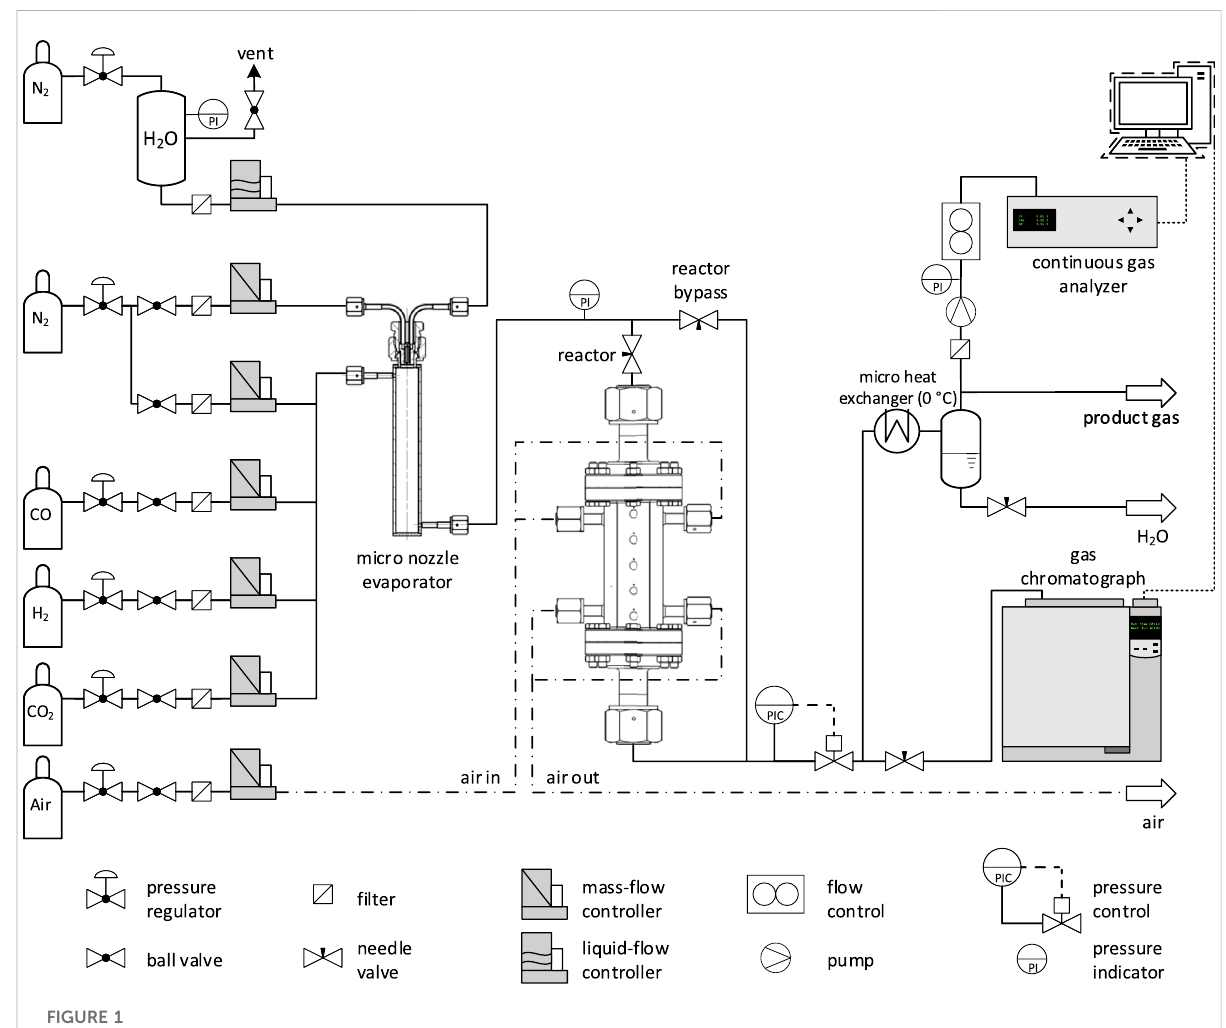
FIGURE 1 Schematic drawing of the experimental laboratory SEWGS setup Stadler et al.